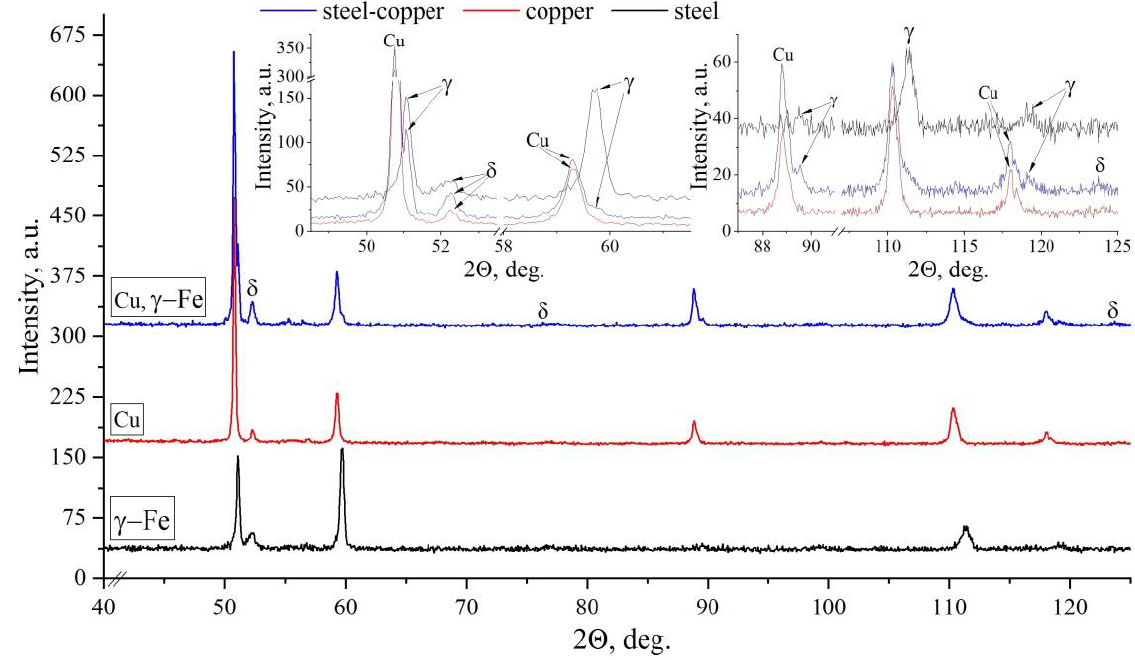
Figure 13. X-ray diffraction of bimetal laminate macrocomposite in zones I, III and IV–V boundary of “SS–Cu”.